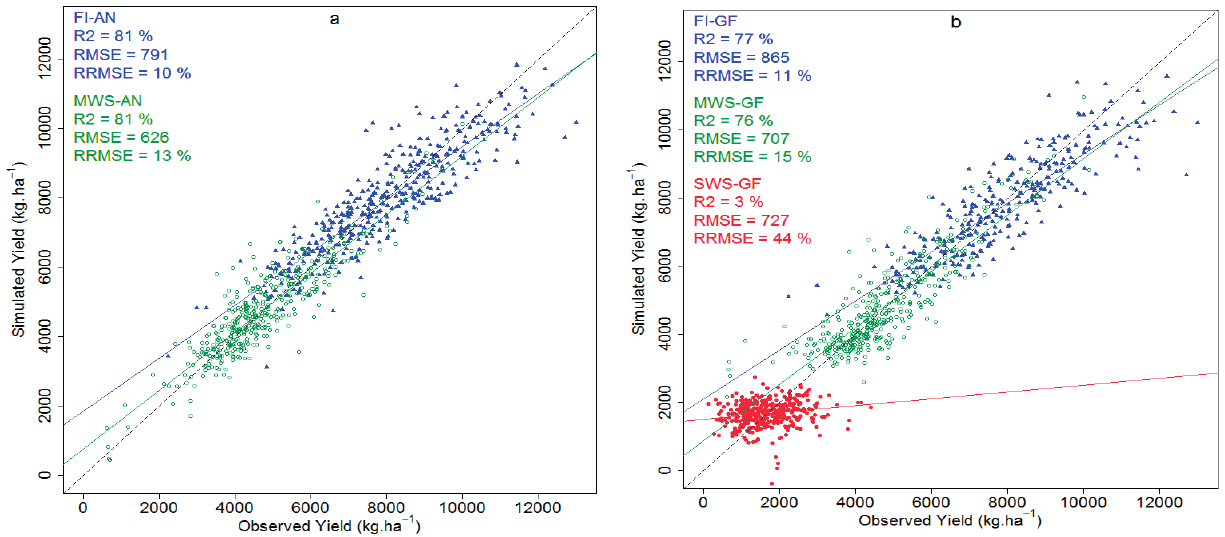
Figure 4. Comparison of observed grain yield (kg·ha − 1 ) by using regression coefficients of combined models for the phenological stages of ( a ) anthesis and ( b ) grain filling. R 2 : coefficient of determination, RMSE: Root Mean Squared Error, rRMSE: Relative Root Mean Squared Error, red dots correspond to SWS, green dots to MWS, and blue dots to